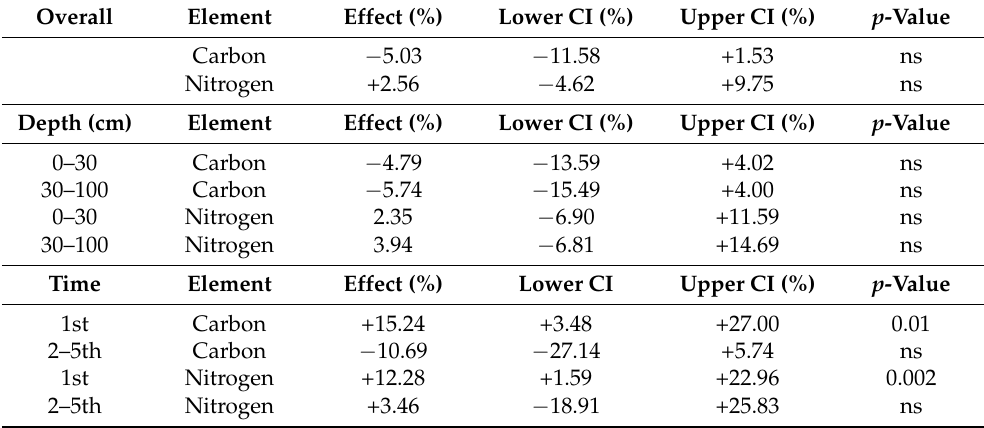
Table 3. Effect of reversion of perennial crops on soil C and N stocks according to soil depth and